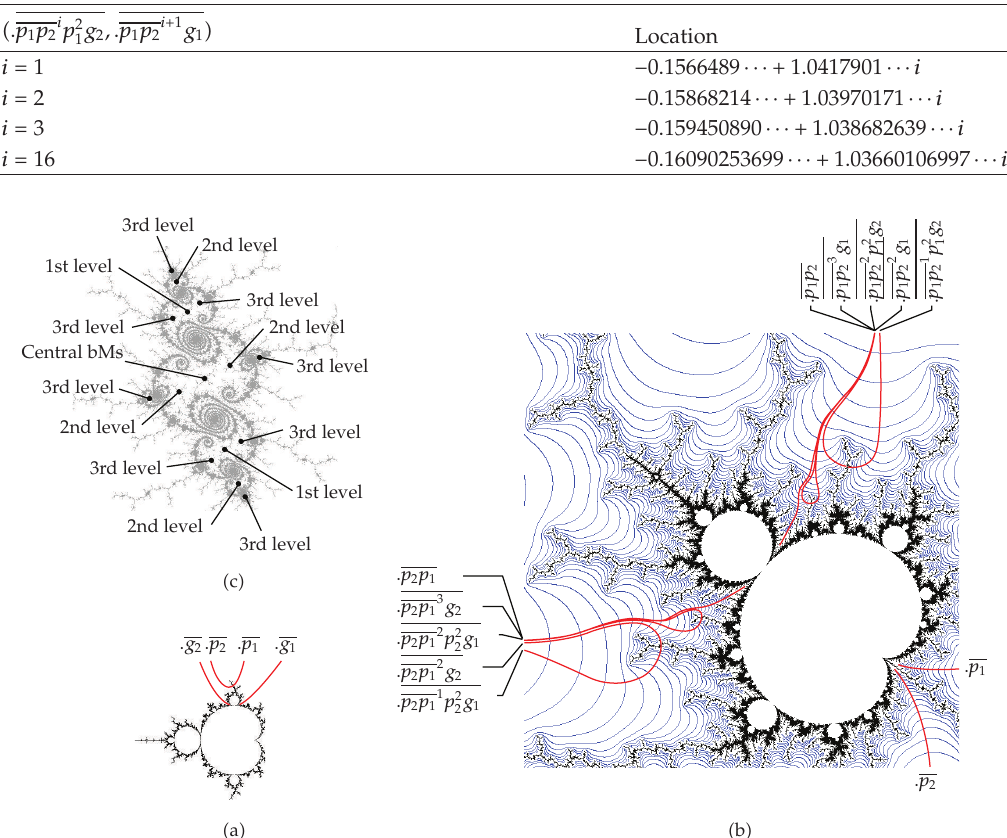
g 2 ,.p 1 p 217 g 1 (cid:5) where the BMSs 1